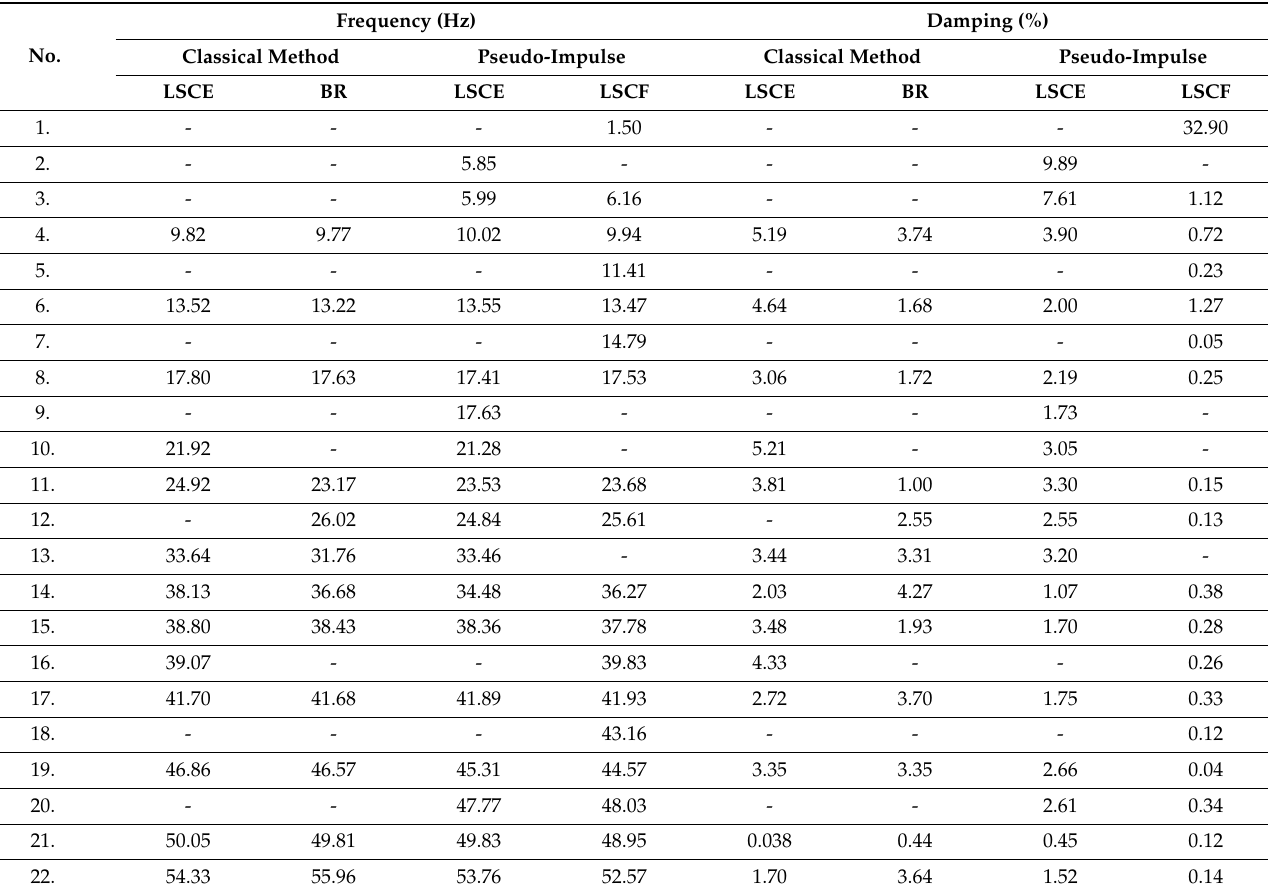
Figure 13. Stabilisation diagrams obtained for the pseudo-impulse approach with the application of the LSCE ( left ) and LSCF ( right ) methods. Tables 1 and 2 present the results of the modal parameter estimation. In the consecutive rows, the corresponding poles of the modal model are gathered. As the main comparison criterion, the frequency at which individual poles appear was assumed. Table 1. Comparison of modal parameters estimated with the application of classical and pseudo- impulse methods (modes 1–22).